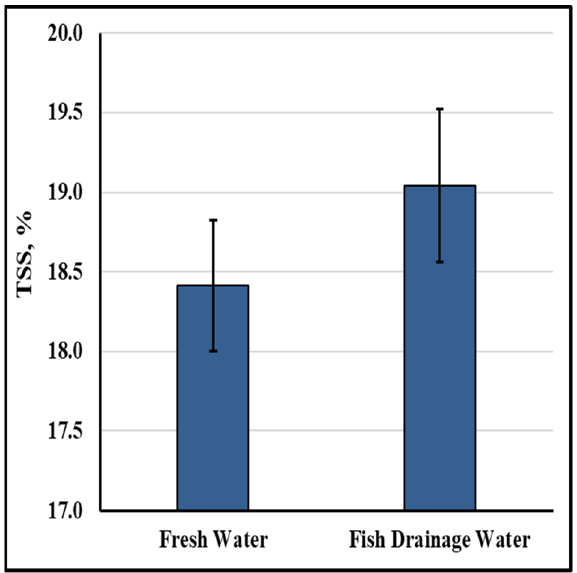
Figure 6. Effect of freshwater and fish drainage water in combination with different organic fertilizer types on Total soluble solids content (TSS) of the fruit juice.